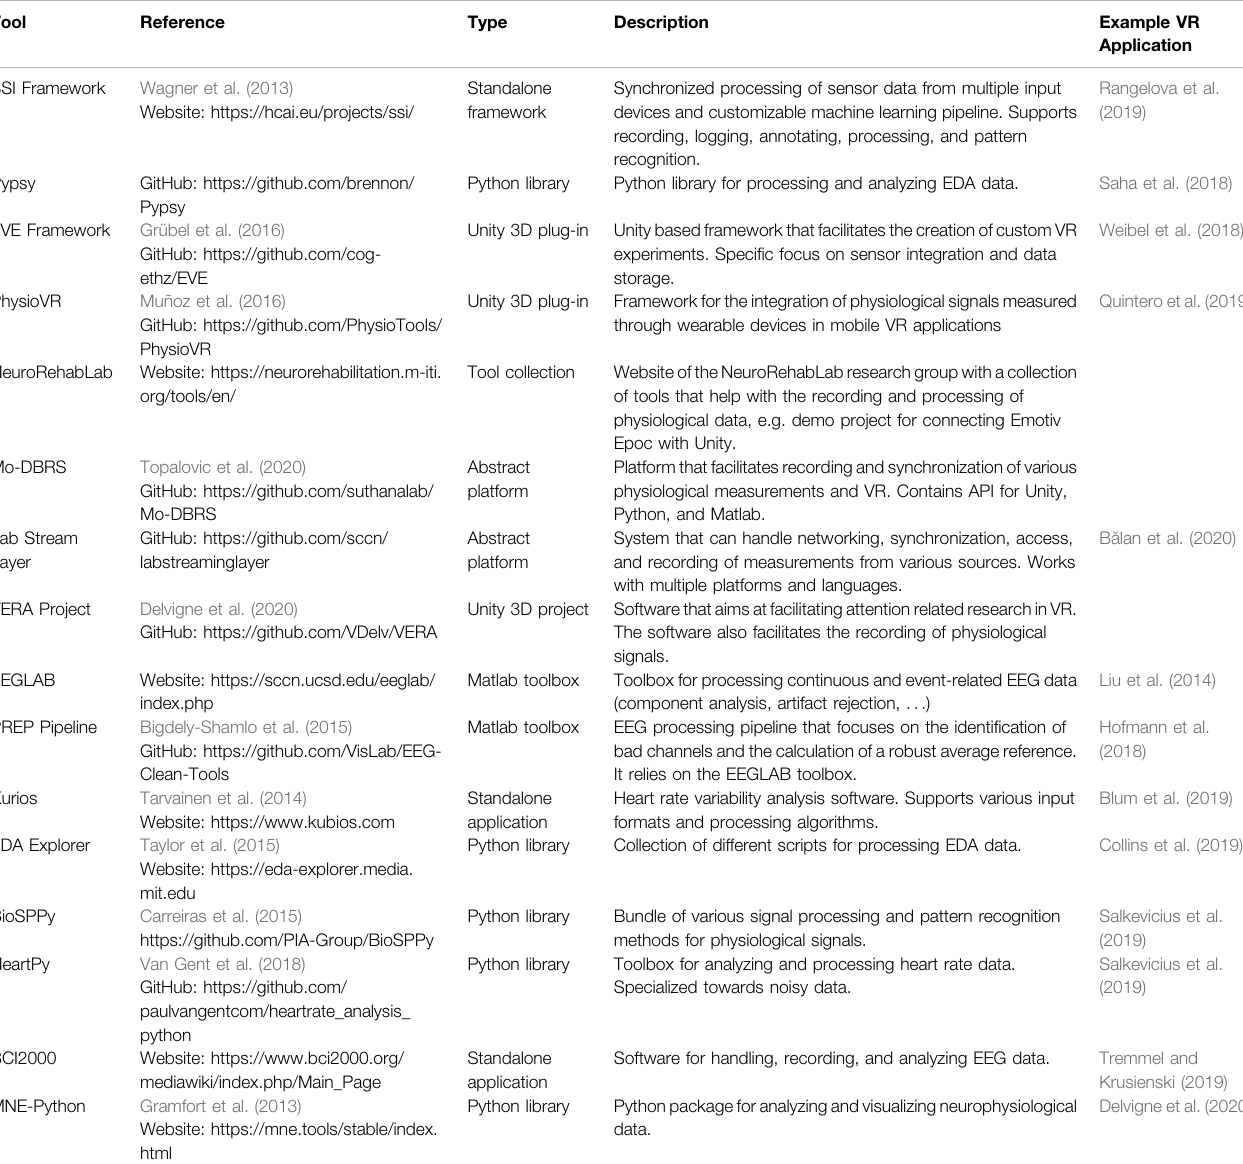
TABLE 4 | Various tools that were used in the identi fi ed classi fi cation approaches for the recording, synchronization, and processing of physiological